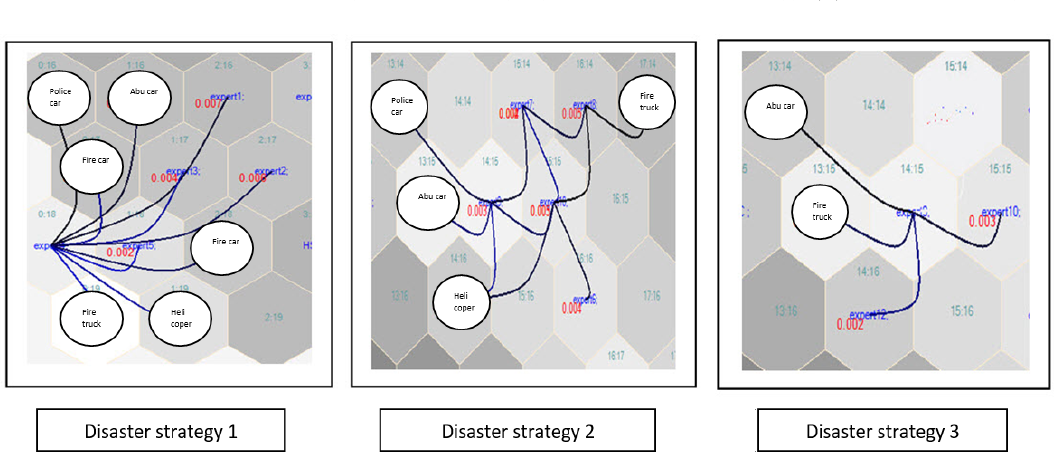
Figure 5. The SOM map results in viewed vehicles in emergency strategies.